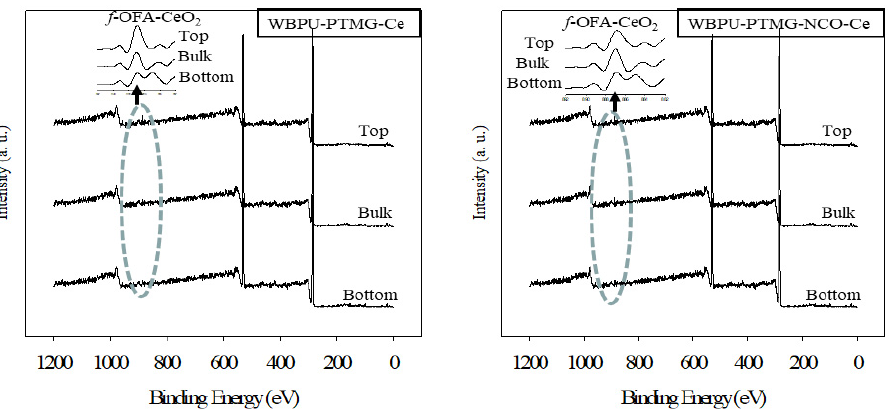
Figure 3. XPS scan of WBPU-PTMG-Ce and WBPU-PTMG-NCO-Ce films.